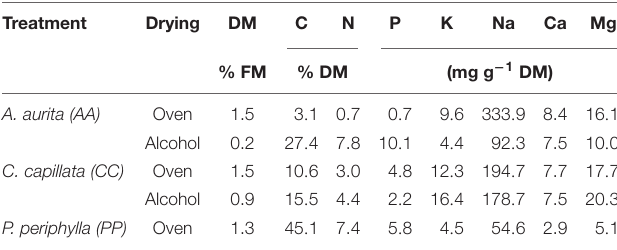
TABLE 1 | Chemical analysis of the dry matter (DM) of the different jellyfish species and different processing methods (oven- and alcohol drying). Treatment